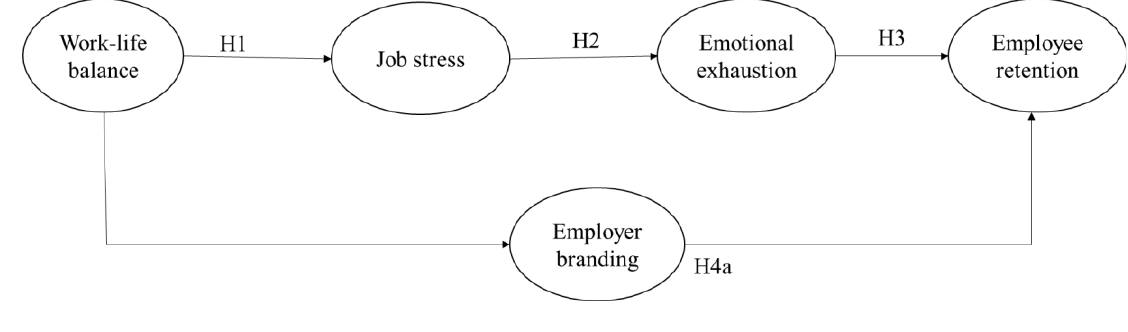
Figure 1. Employer Branding as Mediating Variable (Model 1)